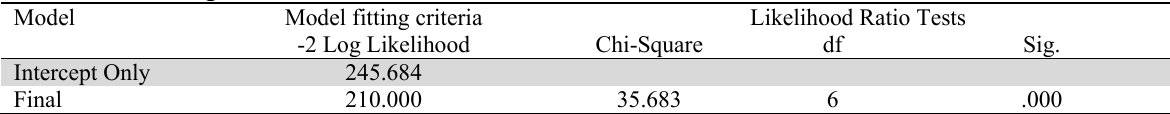
Information Fitting Model Model Model fitting criteria Likelihood Ratio Tests -2 Log Likelihood